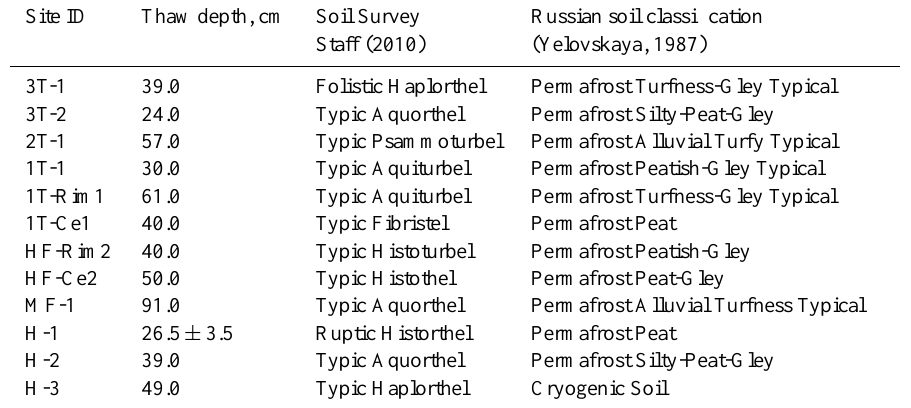
Table 2. Soil classification of investigation sites according to Soil Survey Staff (2010) and to Russian soil classification (Yelovskaya,